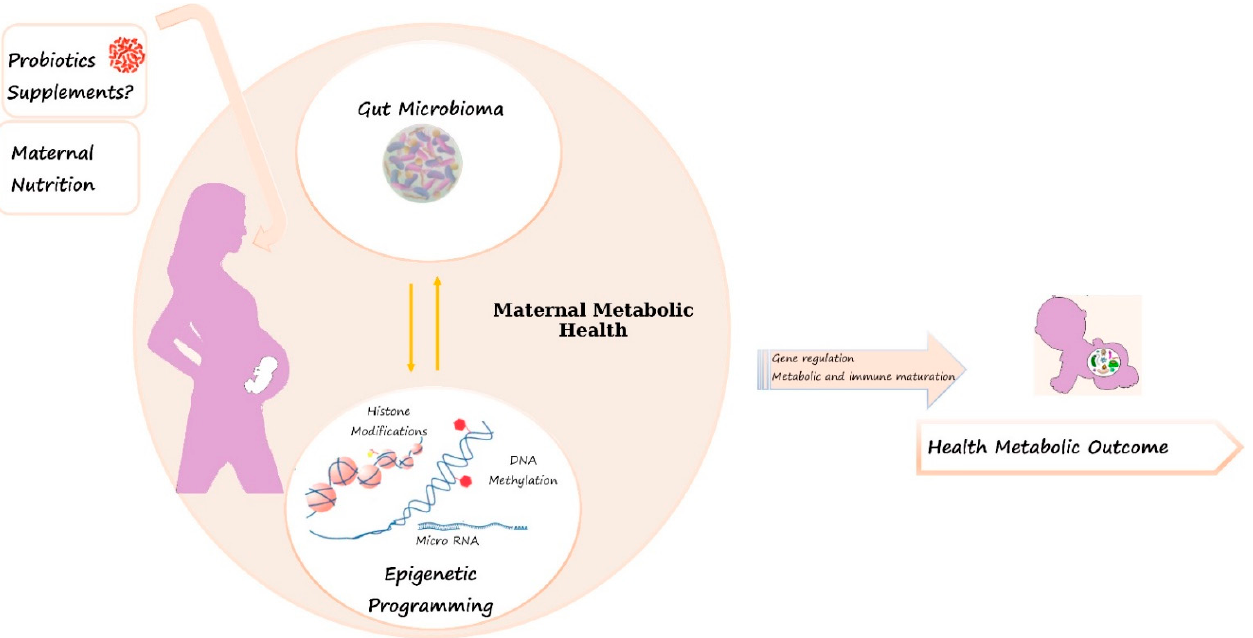
Figure 1. The complex interactions among early nutrition, microbiome, epigenome and long-term health development.